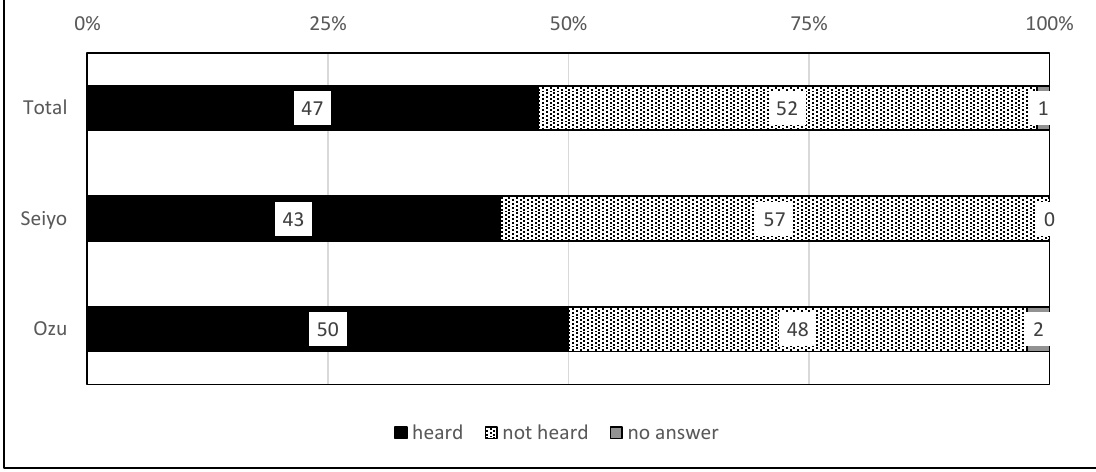
Figure 12. Feelings induced when residents heard the evacuation instructions (%), n = 37, (multiple answers). We asked participants who heard the evacuation instructions how they heard them. Sixty percent of participants in Seiyo said they heard the evacuation instructions from “firefighters, police, or city officials” (Figure 13). This group would have included volunteer fire corps considering that the evacuation instructions were issued early in the morning and many members of the flood-fighting corps were working in the area. (In Japan, the volunteer fire corps also serve as flood-fighting corps). Furthermore, at this time, the headquarters of the volunteer fire corps asked members to visit each house to recommend residents to evacuate. The volunteer fire corps were thus the most effective channel through which evacuation instructions were communicated in Seiyo. In addition, 27% of respondents heard evacuation instructions via indoor receivers of the DRS, which were installed in almost all households in the Nomura area of Seiyo. In Ozu, 55% of respondents heard evacuation instructions via loudspeakers of the DRS, 41%